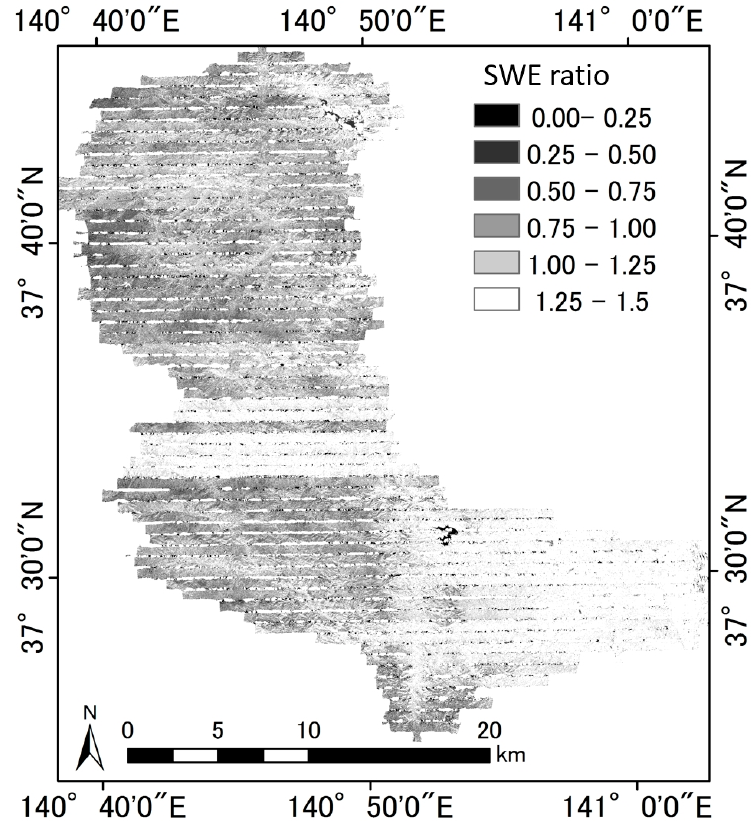
Figure 11. Distribution of the ratio between SWE obtained using ρ (t) and SWE obtained using ρ a .